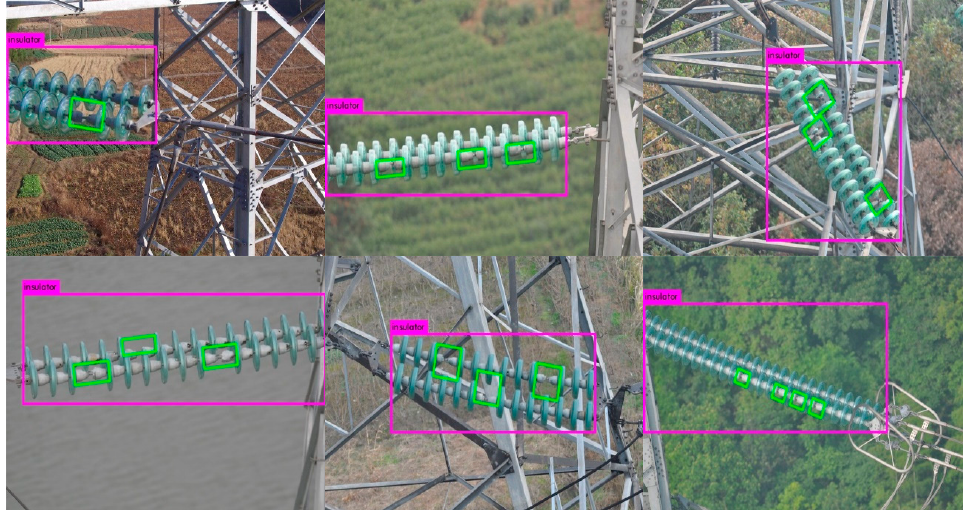
Figure 12. Insulator faults detection results under different aerial scenes. The pink bounding boxes give the insulators positions and the green bounding boxes indicate the detected insulator faults positions.